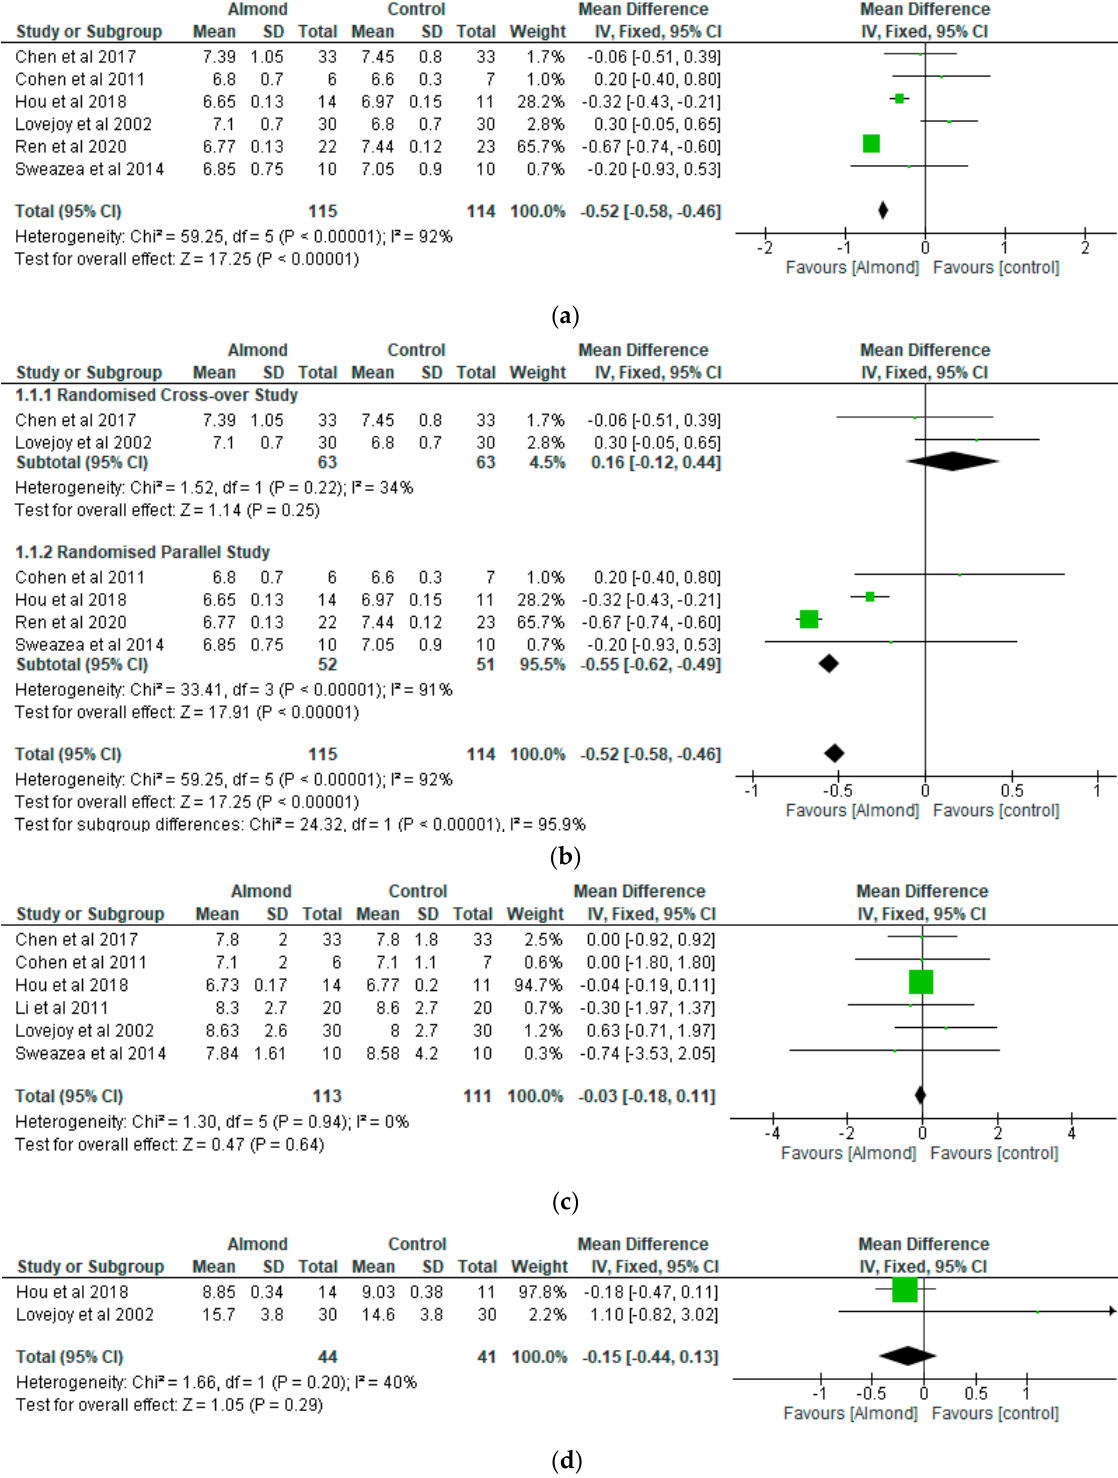
Figure 3. The effect of almonds on ( a ) glycated haemoglobin (Hba1c, %), ( b ) Hba1c (%)—subgroup analysis; ( c ) fasting blood glucose (mmol/L); ( d ) 2 h postprandial blood glucose (mmol/L).